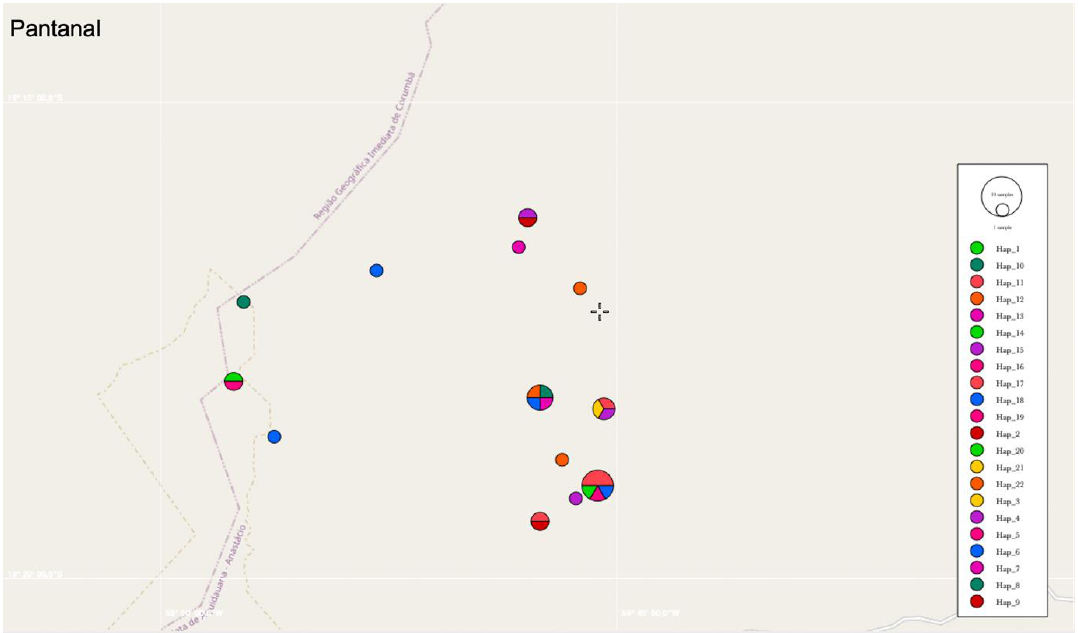
Figure 7. Representation of the genotype distribution of Pantanal biome areas. Map was constructed using PopART software based on GPS coordinates data of each sampling.